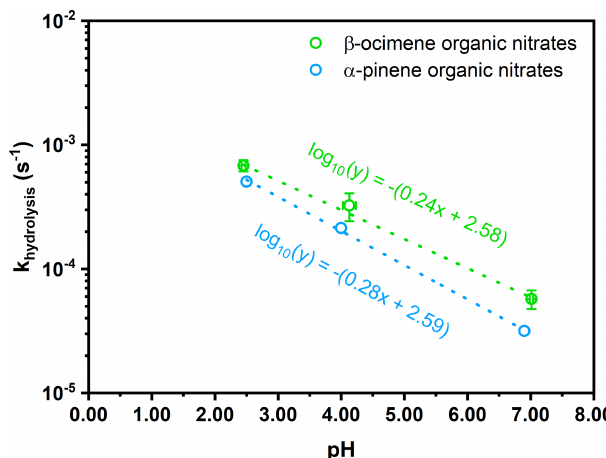
Figure 9. Hydrolysis rate constant for β -ocimene hydroxy nitrates (this study, green) and α -pinene hydroxy nitrates (Rindelaub et al., 2015, blue) as a function of pH. The lines of best fit are listed in the colors corresponding to each monoterpene organic nitrates. Error bars represent the standard deviation between measurements of both the hydrolysis rate constant ( y error) and pH ( x